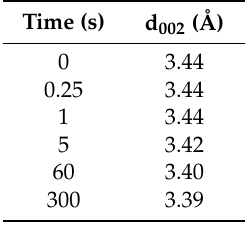
Figure 13. TEM micrograph of sucrose char after 1 s at 2600 °C.